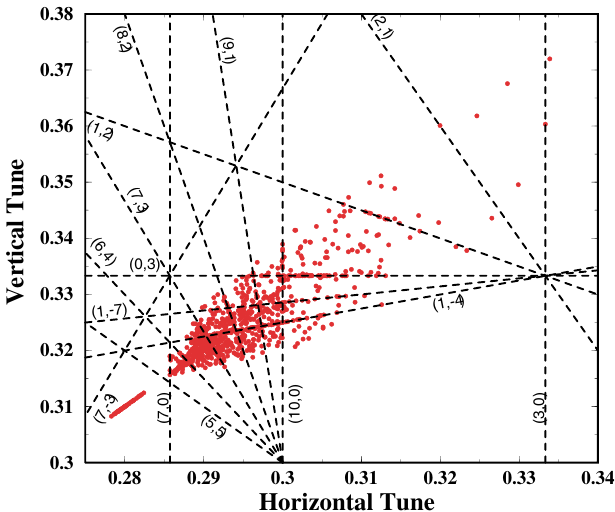
FIG. 66. (Color) LHC tune footprint obtained by a frequency- map analysis [89] for particle trajectories tracked through a frozen electron potential at the tail of a bunch with one IP per turn [88]; the tune spread is about 20 times larger than that expected from the unperturbed cloud.